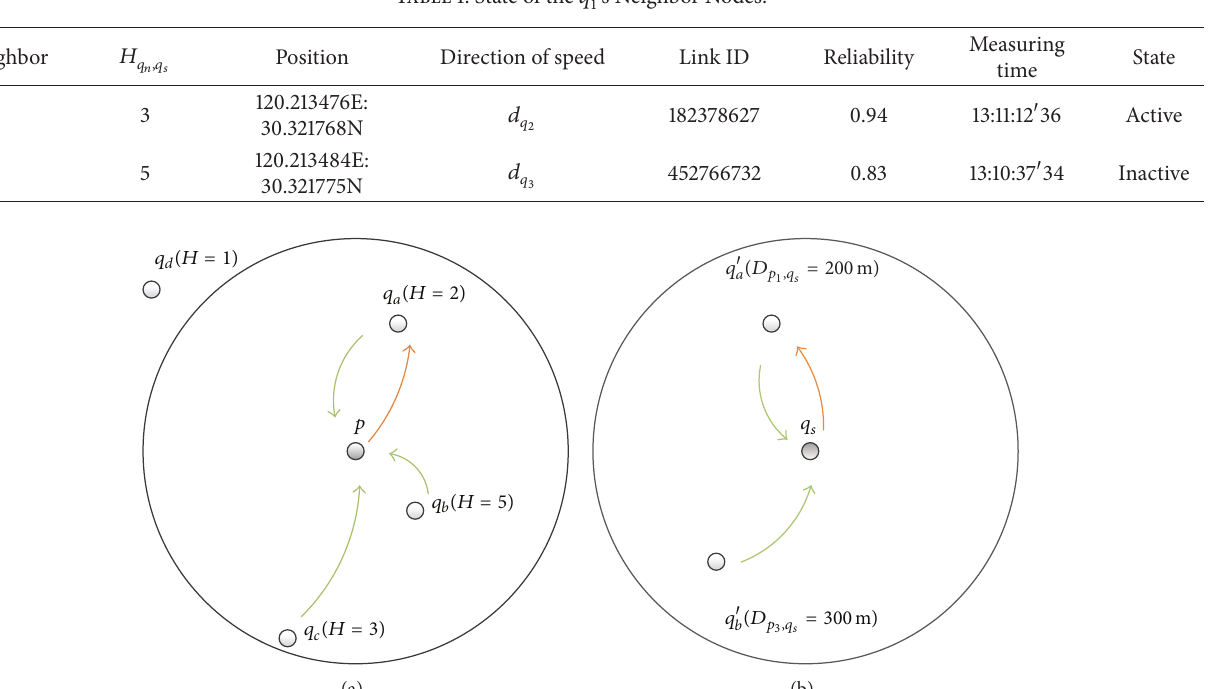
Table 1: State of the 𝑞 1 ’s Neighbor Nodes.